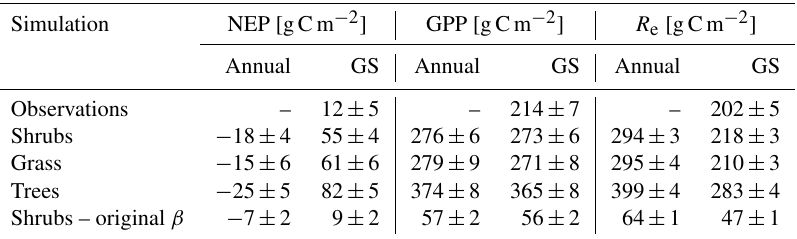
(Table 5), EC-based NEP ( − 19 ± 1 g C m − 2 ) for the 81 d that EC flux data were available during the shoulder seasons, and chamber-based NEP ( − 10 g C m − 2 ) for the 131 d that winter EC fluxes were not available (Fig.